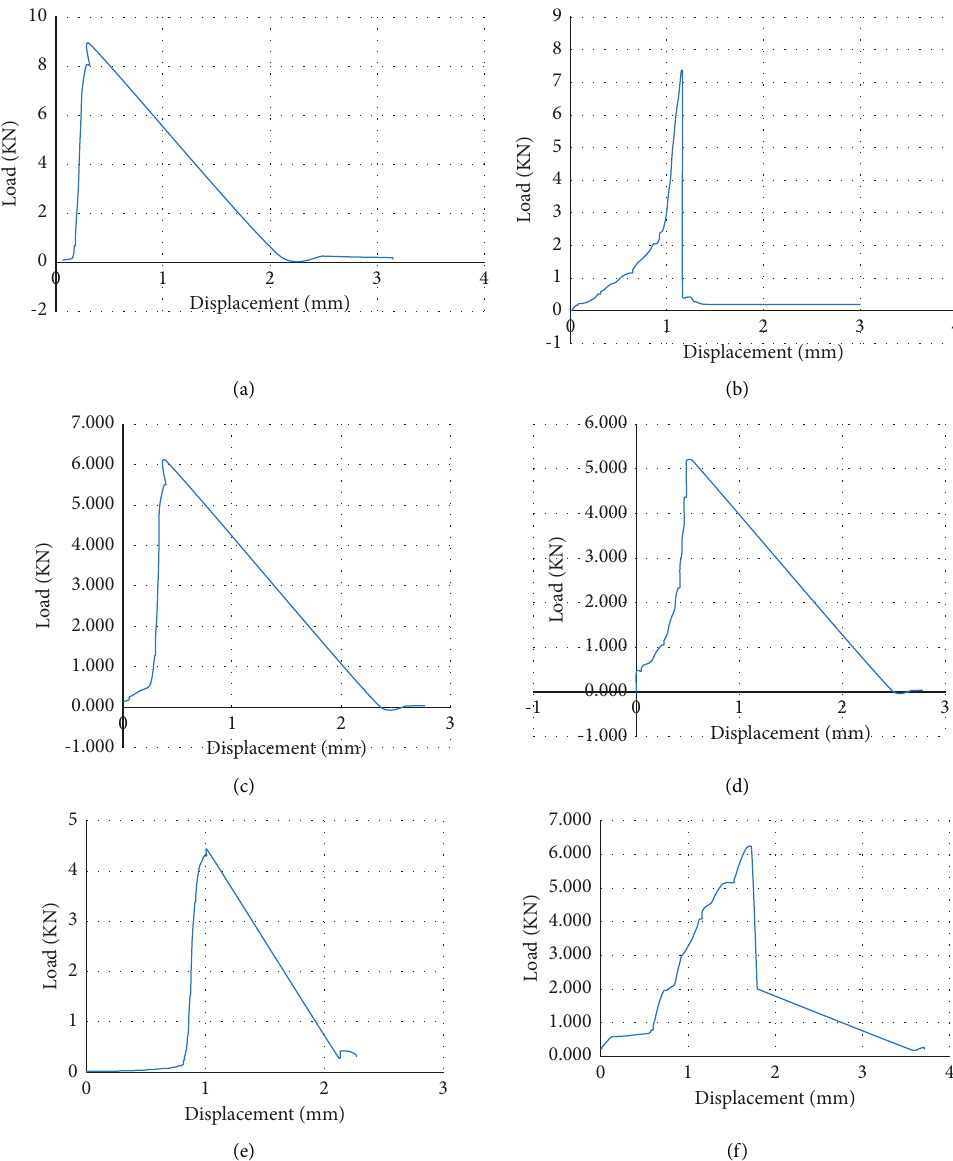
Figure 7: Load-displacement diagram. (a) C40R0, (b) C30R10, (c) C20R20, (d) C10R30, (e) C0R40, and (f)